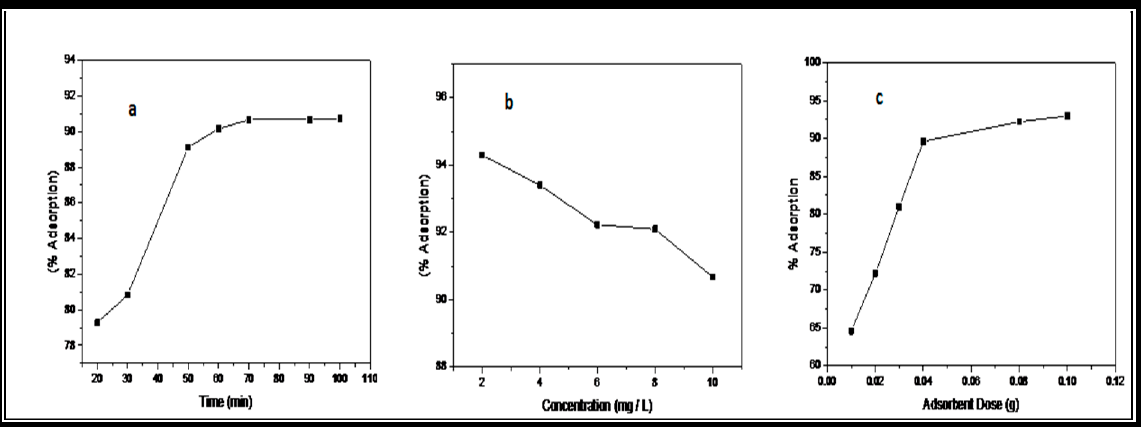
Figure 4. Plots of ( a ) contact time; ( b ) initial dye concentration, and ( c ) PNB dose vs. adsorption for a PNB–MB adsorption system.